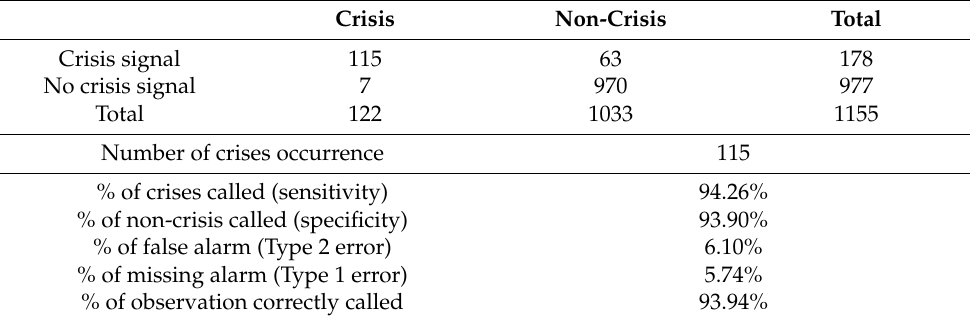
Table 7. Probability of predictability of the 12-month EWS model (cut-off = 13.27%).